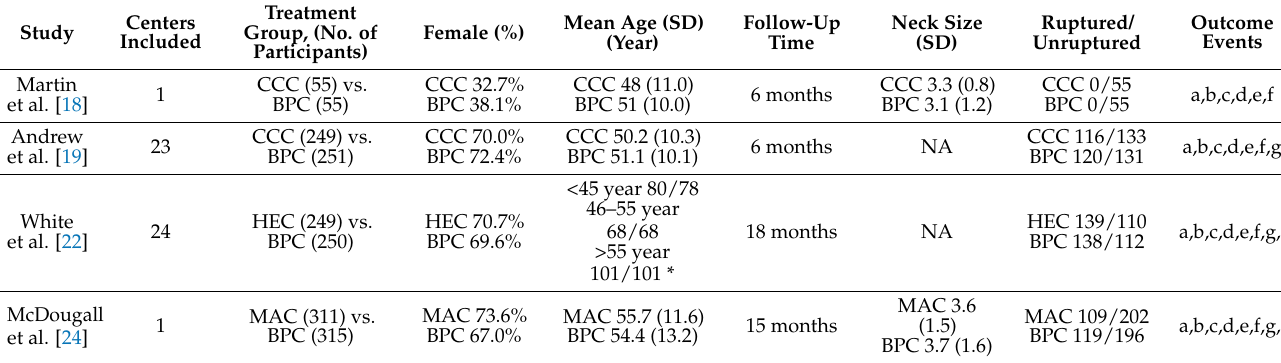
Table 1. Characteristics of the Included Studies and Outcome